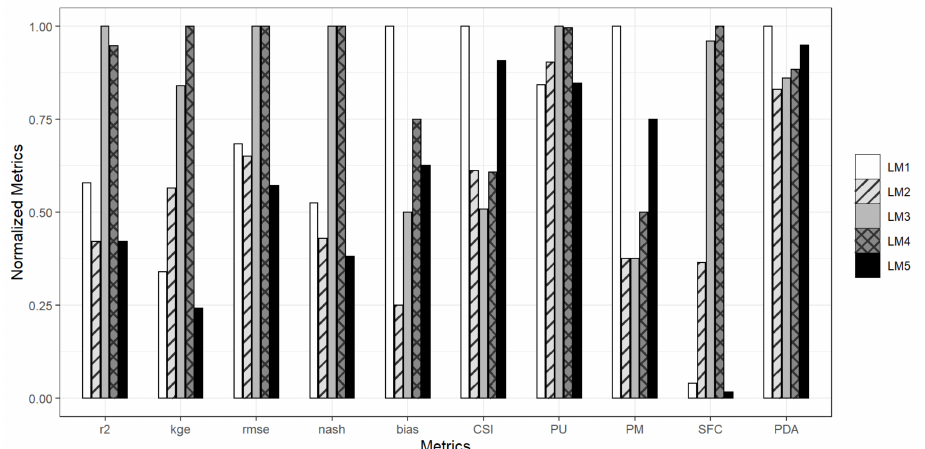
Figure 12. Normalized metrics (quantification and detection s) for the mean of all the classic logistic models. For normalized indexes, the range is [0–1], where the best model has a value of